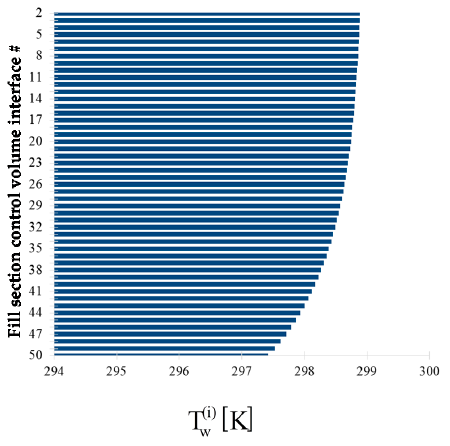
( i ) T , ( 2,...,50) = i , at the exit of each control T , ( 2,...,50) = i , at the exit of each control ( i = 2,...,50 ) , at the exit of each control volume T , ( 2,...,50) = i , at the exit of each control w , w w w